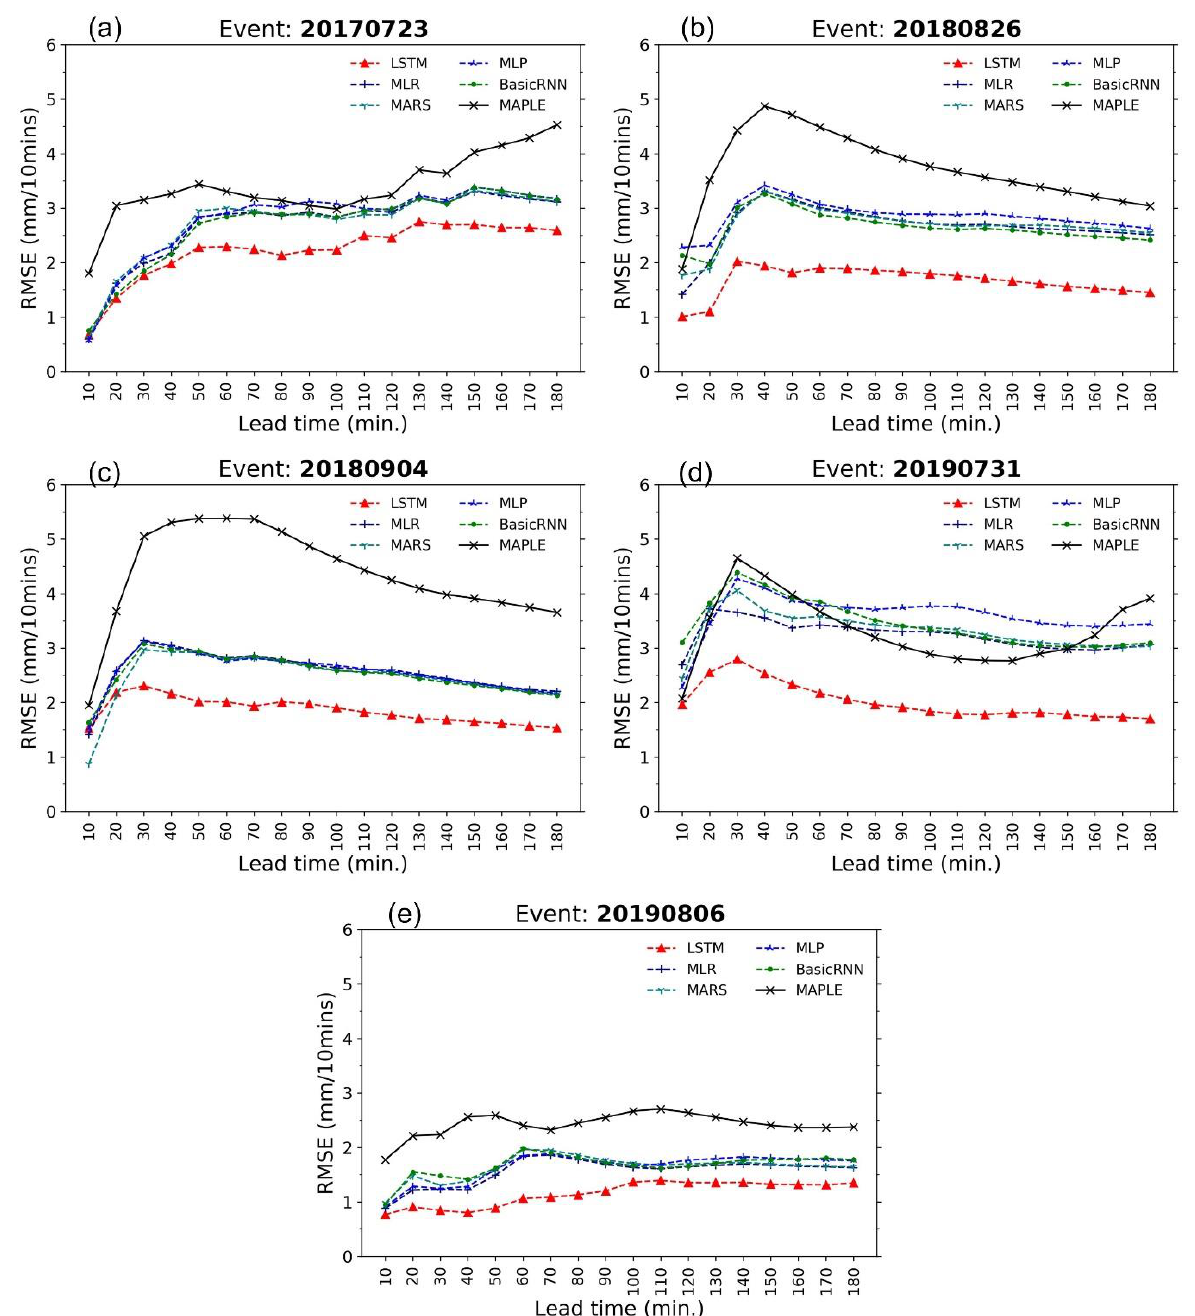
Figure 6. Root mean square error ( RMSE ) of the forecasted rainfall from the MAPLE system and data-driven models in reproducing 180 min forecast rainfall in the 5 test events: ( a ) 20170723 event, ( b ) 20180826 event, ( c ) 20180904 event, ( d ) 20190731 event, and ( e ) 20190806 event.